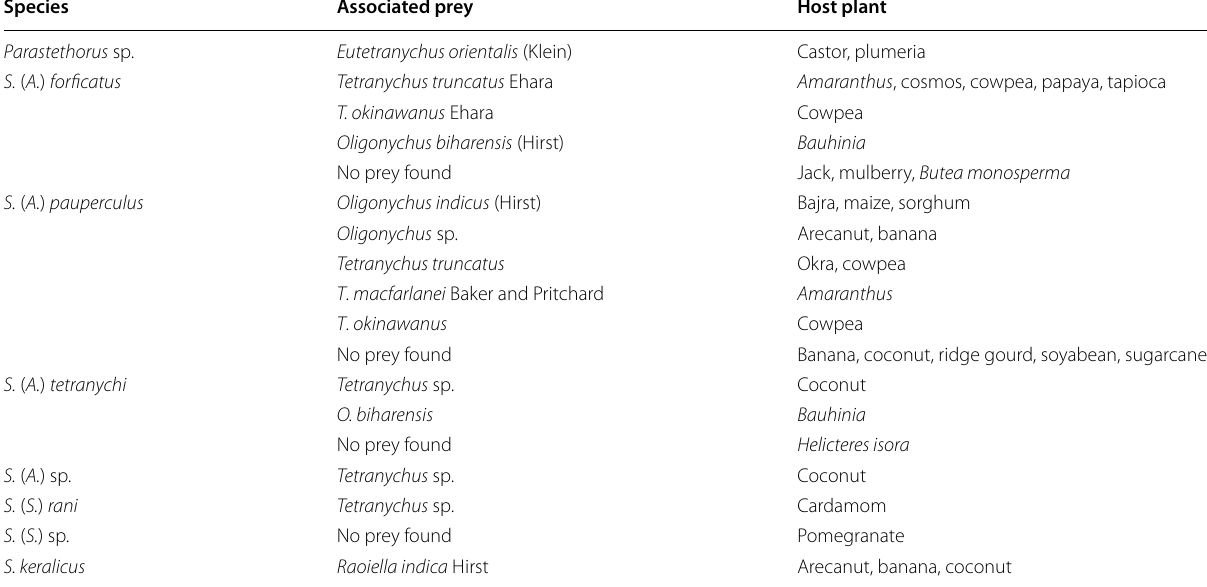
Table 3 Stethorini species associated with different mite species Species Associated prey Host plant Parastethorus sp.